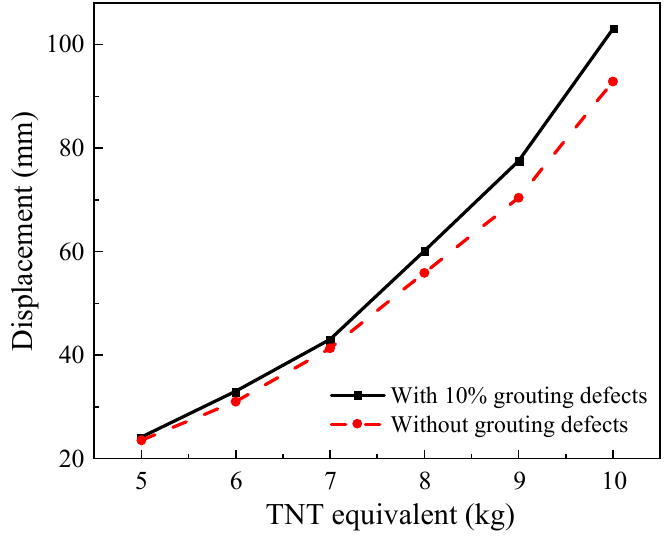
16 of 19 ( b ) Figure 21. Displacement nephograms of the grouting sleeve and reinforcement under an explosive equivalent of 10 kg. ( a ) Without grouting defects. ( b ) With 10% grouting defects. From the comparison of the peak displacement diagrams for different TNT equiva- lents without defects and considering defects (Figure 22), it can be seen that with the in- crease in the explosive equivalent, the difference between the peak displacements in- creases continuously. When the explosive equivalent increases to 10 kg, the peak displace- ment of the shear wall considering defects increases by 9.87% compared with that of the shear wall without grouting defects, and the anti-explosion performance of the wall de-